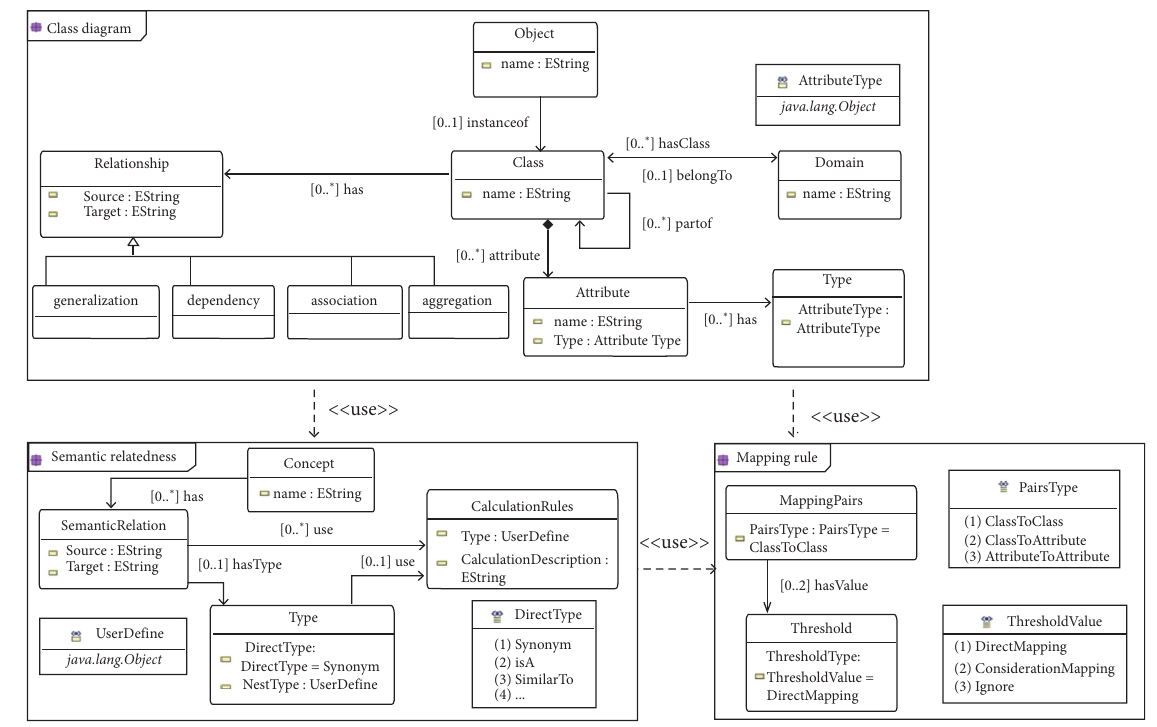
Figure 2: A brief illustration of SbACMT_MM.